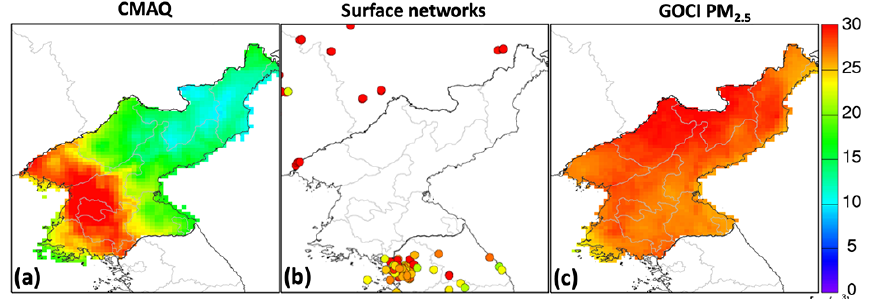
Figure 12. Mean PM 2 . 5 concentrations in North Korea in 2016, as simulated by CMAQ and as represented by the GOCI PM 2 . 5 product, assuming that South Korea is a categorical variable. Panel (b) shows surface PM 2 . 5 concentrations from the AirKorea and China Ministry of Ecology and Environment (MEE)